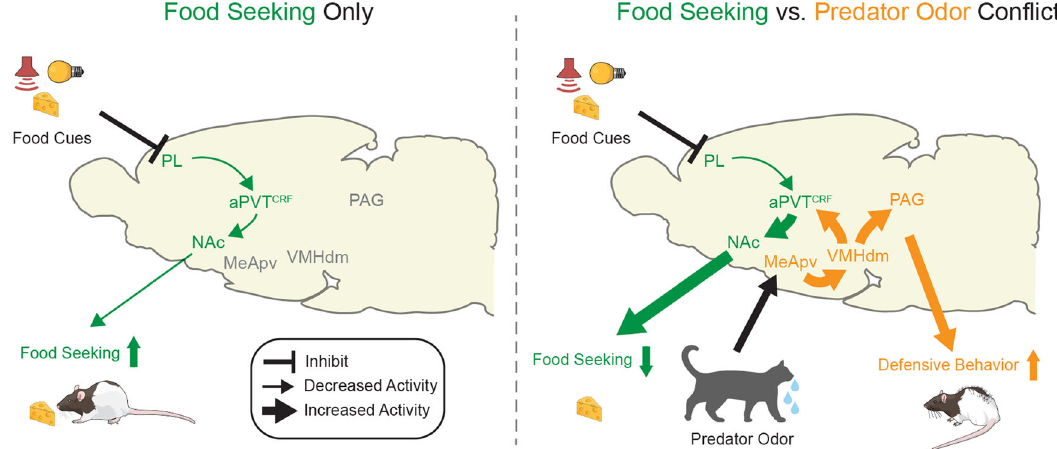
Fig. 10 Schematic of our proposed model for the neural networks regulating predator-threat vs. food-seeking con fl ict. (Left) During food-seeking behavior, food-associated cues inhibit the activity of PL glutamatergic neurons that project to aPVT CRF , resulting in reduced activity in the aPVT CRF -NAc projection and consequently increased food-seeking responses 14 . (Right) During food-seeking vs. predator-threat con fl ict, cat odor activates MeApv neurons that project to VMHdm 50 . Subsequent activation of VMHdm neurons that project to PAG mediates defensive responses 51 , whereas activation of VMHdm neurons that project to aPVT CRF suppresses food seeking (Supplementary Fig. 8a – c). Increased activity in the aPVT CRF -NAc pathway leads to target-dependent synaptic transmission in the NAc (Fig. 8), thereby reducing food-seeking behavior (Fig.